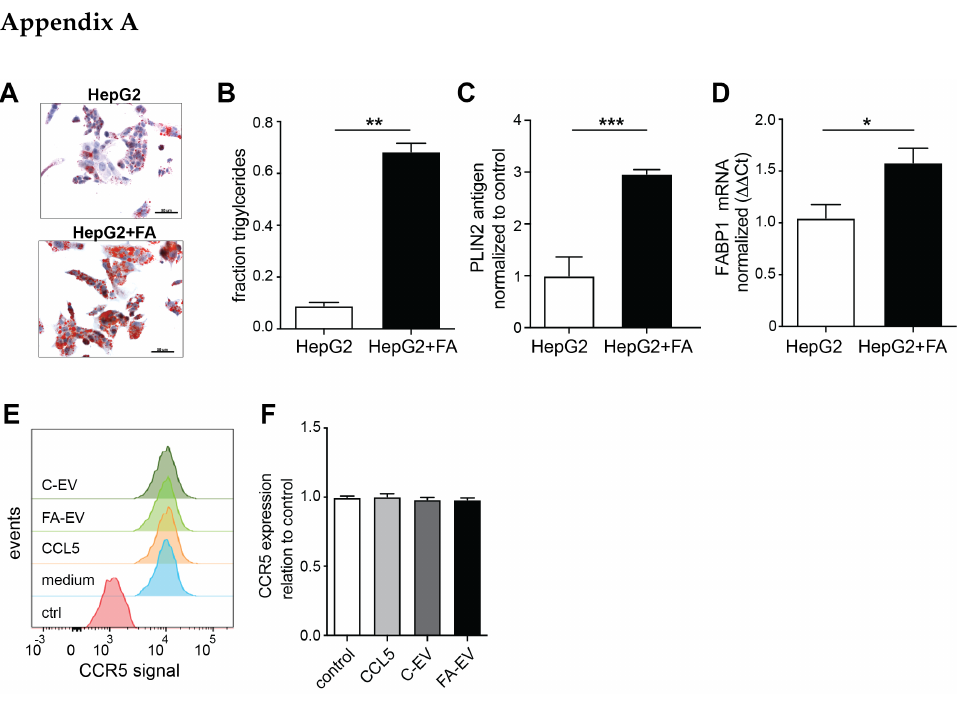
Figure A1. Markers of steatosis in HepG2 cells and effects of EV on CCR5 expression in TWNT4 cells. ( A ) Representative Oil-Red-O staining after treatment with linoleic–oleic acid for 24 h. Scale bar: 50 µ m. Fraction of triglycerides in cell lysates ( B ), antigen levels of PLIN2 ( C ) and mRNA expression levels of FABP1 ( D ) after treatment with linoleic–oleic acid for 24 h. Representative histograms ( E ) and quantitation ( F ) of CCR5 expression of TWNT4 cells after pretreatment with CCL5, C-EVs or FA-EVs. * p < 0.05, ** p < 0.01, *** p < 0.001 with 2-tailed t -test; mean ± SEM (n =